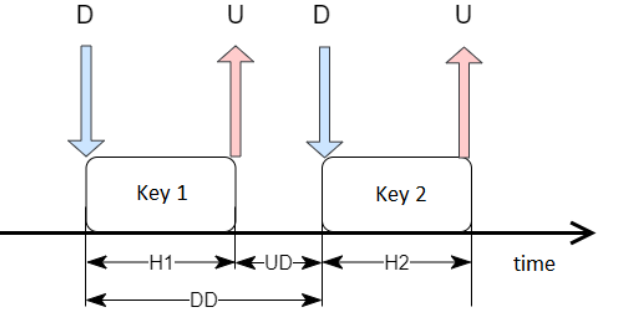
Figure 1. Time dependencies used.